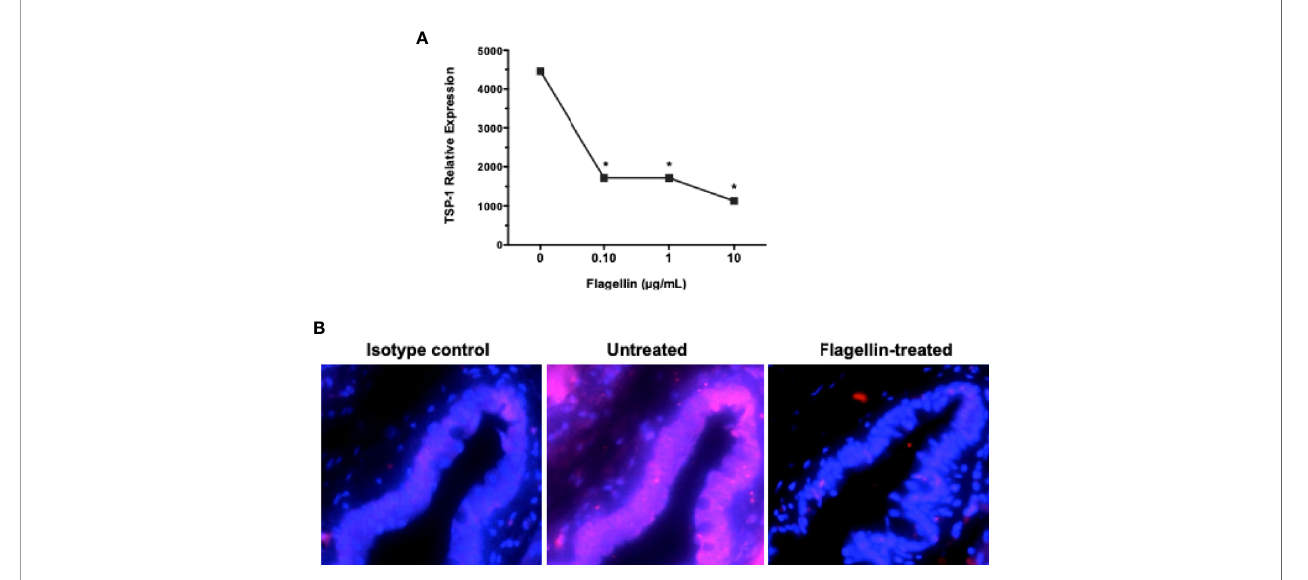
FIGURE 5 | Flagellin stimulation is associated with reduced expression of TGF b -activator TSP-1. (A) The expression of TSP-1 in GC cultures stimulated with indicated concentrations of fl agellin was determined by real-time PCR. Data are expressed as mean ± SEM, n = 4, * p < 0.05. (B) Immunostaining of TSP-1 (magenta) in frozen sections of conjunctiva tissue harvested from C57BL/6 mice 4 weeks after topical application of fl agellin (10 ng/day for 7 days). Nuclei were stained with DAPI (blue). Magni fi cation